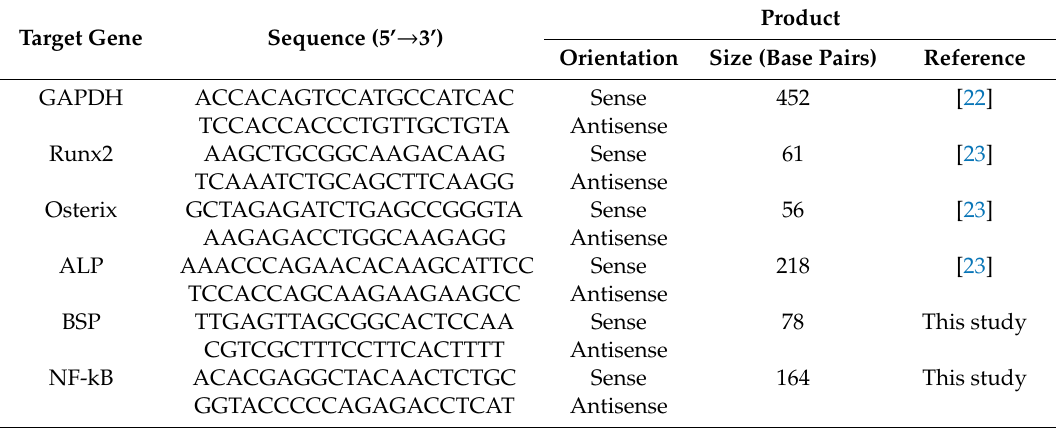
Table 1. RT-PCR primers used in this